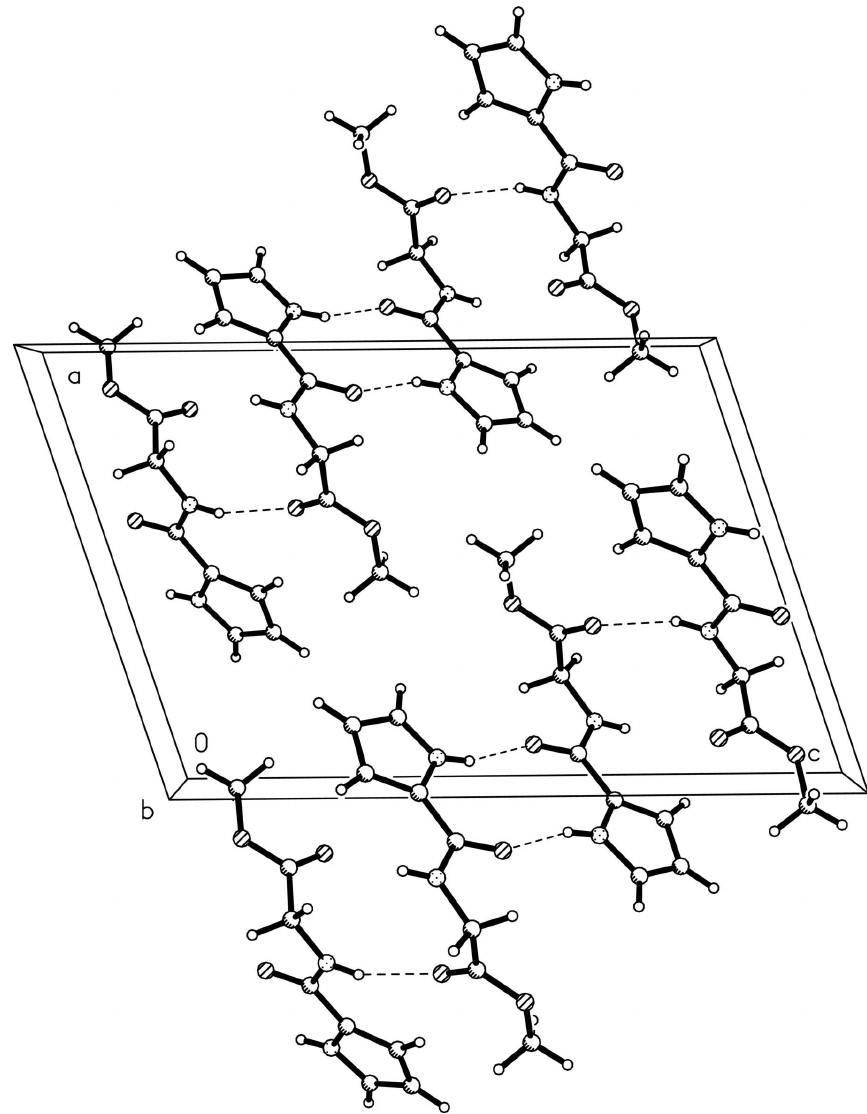
Ribbons of dimers formed by hydrogen bonds (dashed